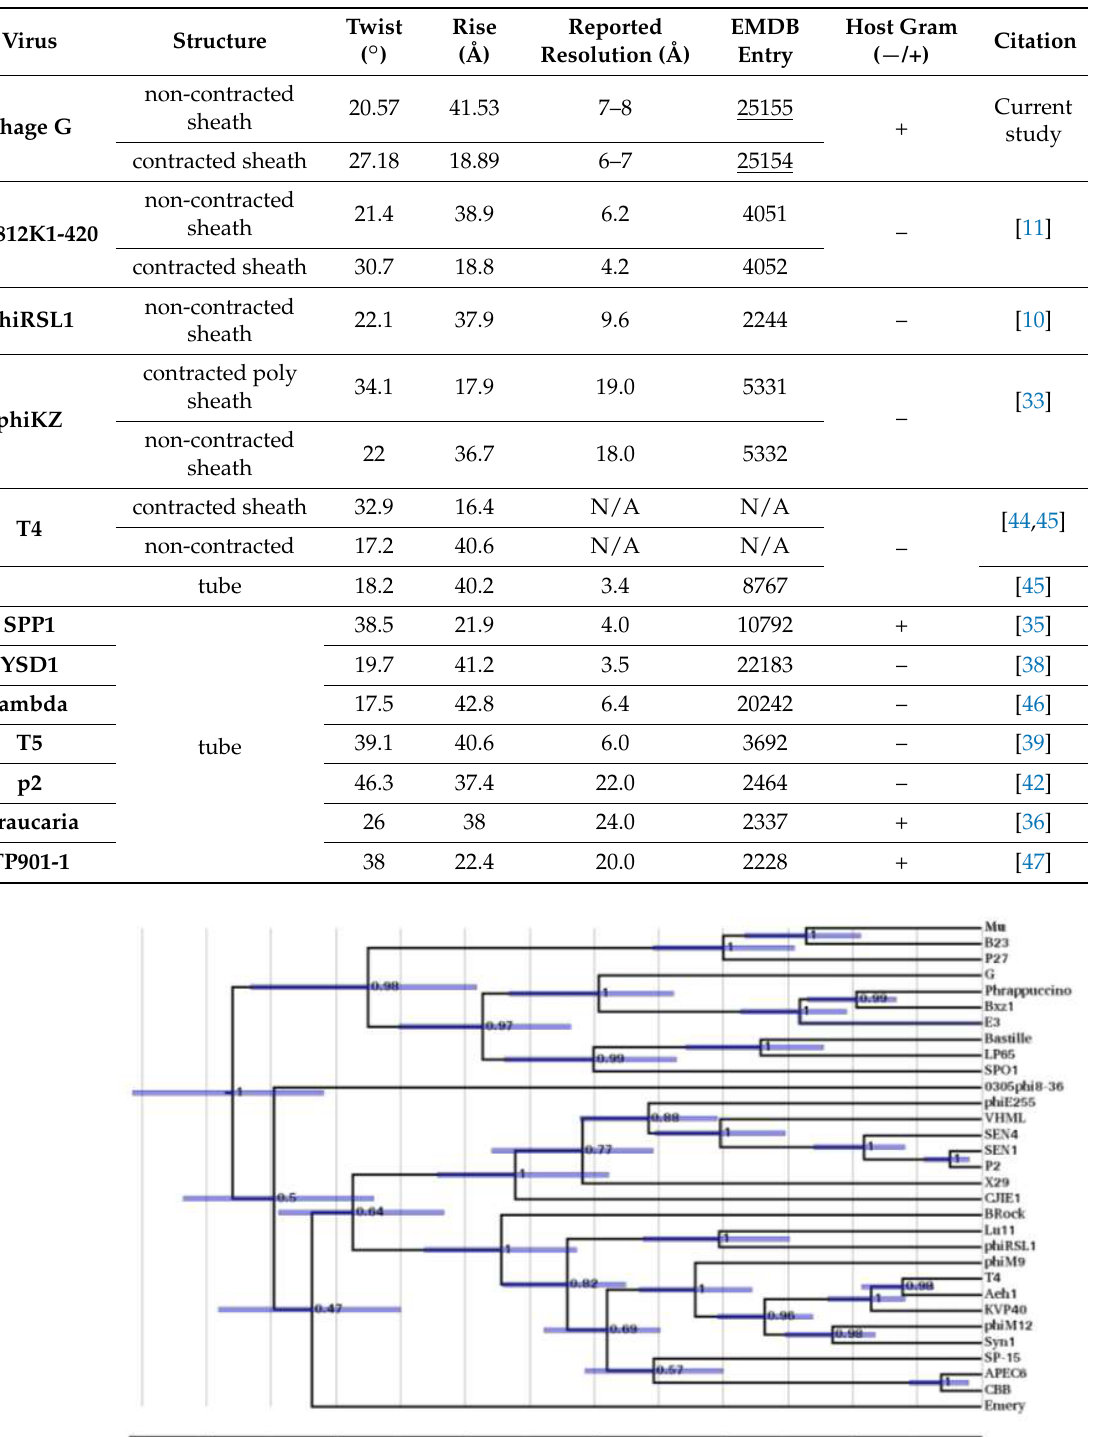
Table 3. Helical symmetry comparison among various phage tails.